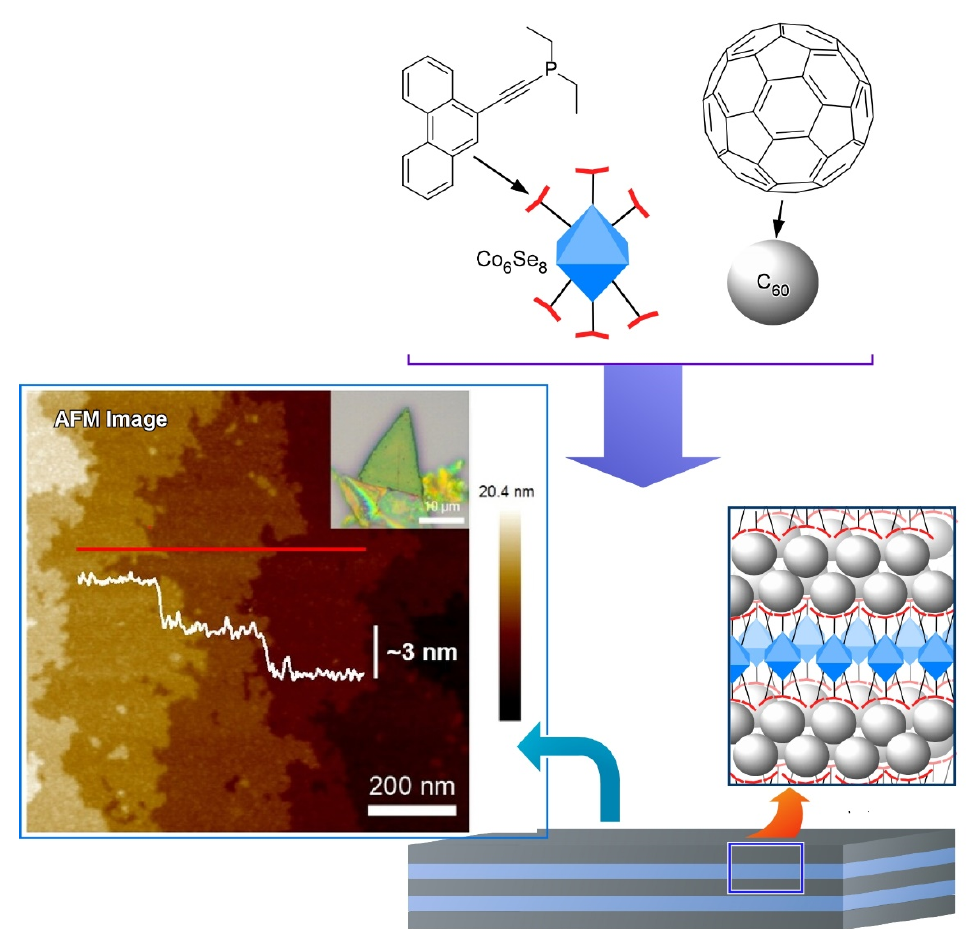
Figure 5. Two-dimensionally confined fullerene as strippable layer of van der Waals solid from a structure-directing building block (Co 6 Se 8 -based cluster) and C 60 fullerene by self-assembly method. Reprinted with permission from [114]. Copyright 2016 American Chemical Society.